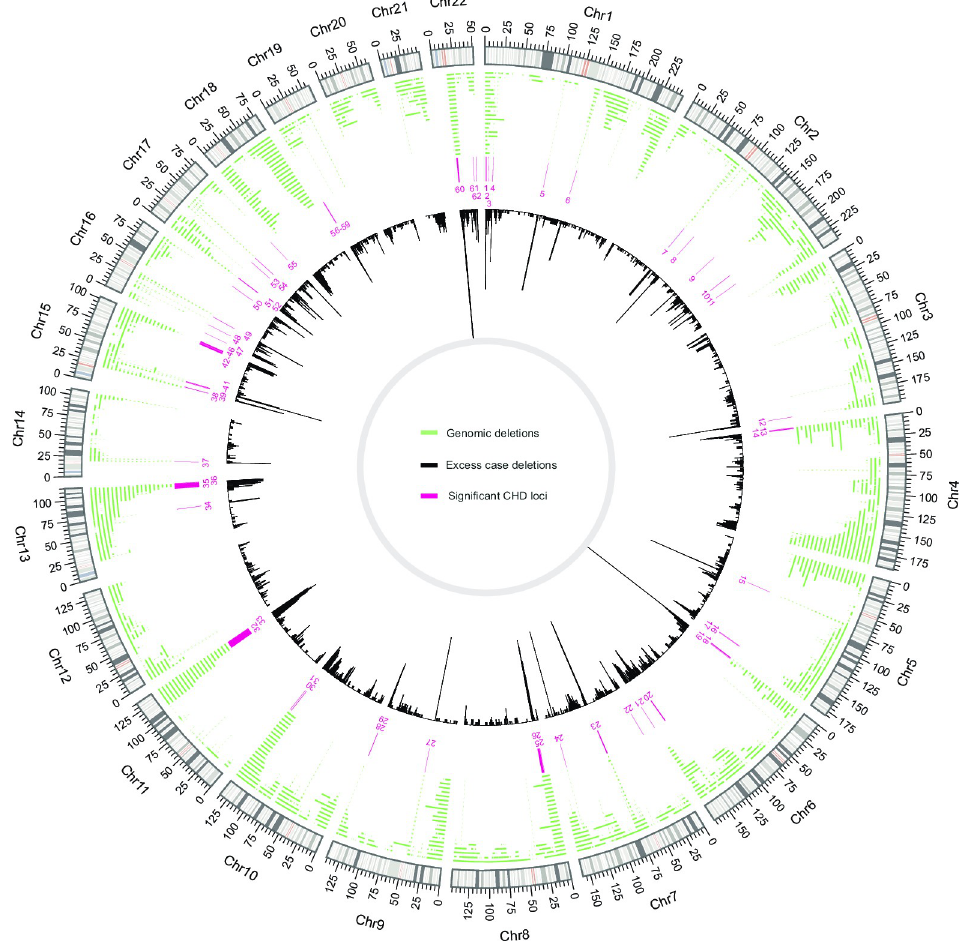
Fig 3. CNV deletion distribution across the 22 autosomes. The plot shows the distribution of rare CNV deletions (green track) in CHD cases, the differences between the overlapping CNV deletions in cases and controls (black track) and highlight the location of the 63 significant loci discovered (in